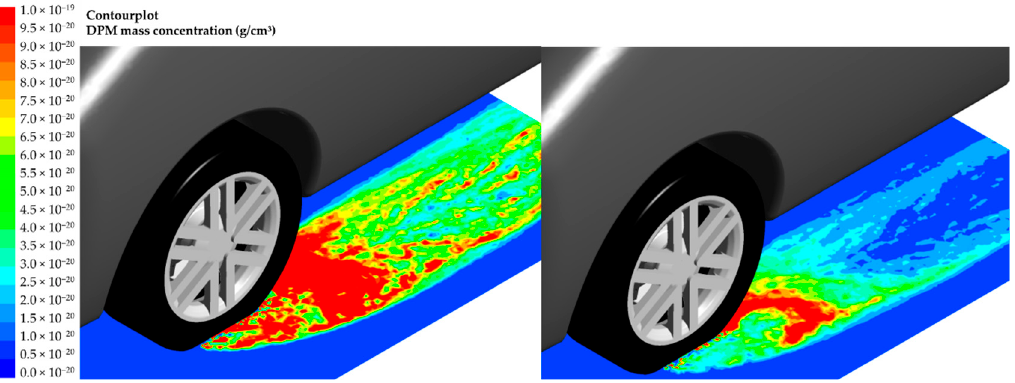
Figure 3. Simulation results for the distribution of 10 µm model particles around the periphery of the wheel with variation of the driving speed (left: 30 km/h; right: 90 km/h). While the smaller particles mostly move along very turbulent tracks and are easily influenced by the flow ( ≤ 1 µm), the larger particles move along much more straight tracks and are not subject to slight changes in flow (>>1 µm).